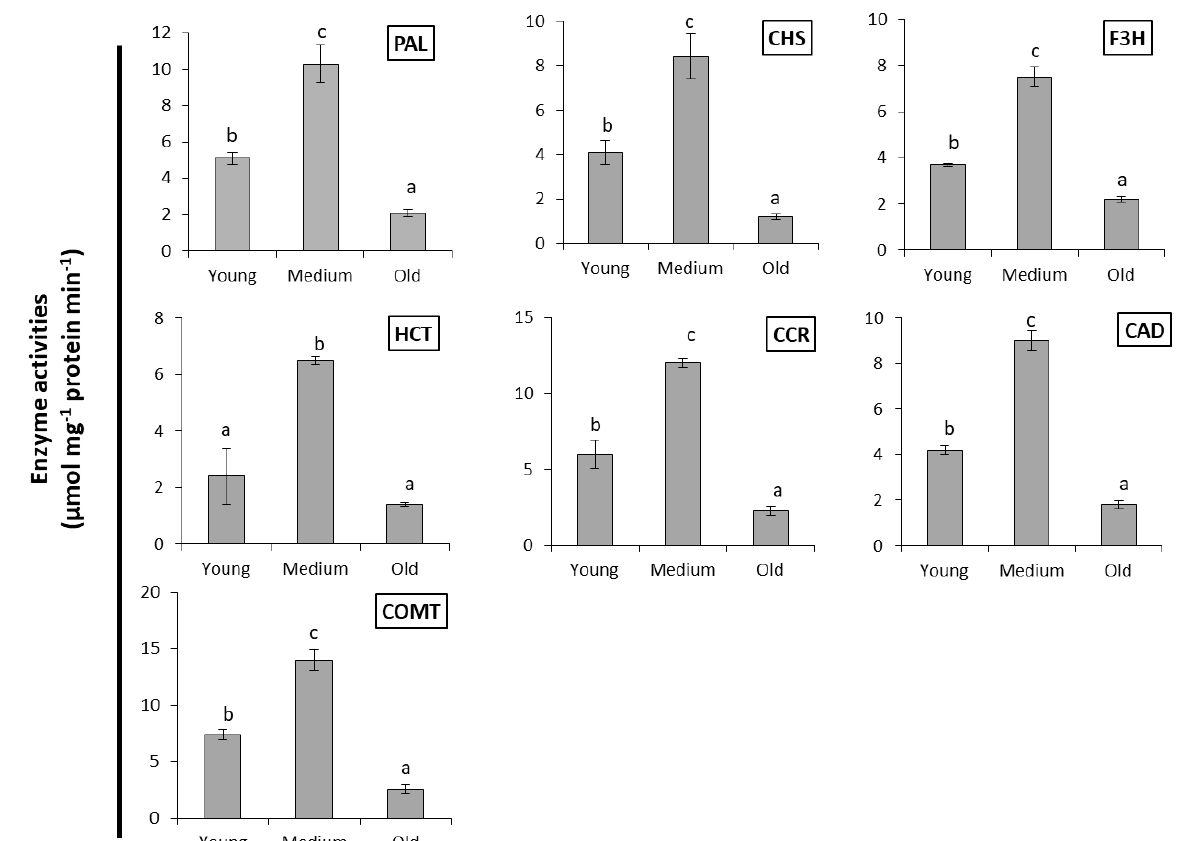
Figure 8. Enzyme activities (µmol mg −1 protein min −1 ) of phenylalanine ammonia lyase (PAL), chalcone synthase (CHS), flavonoid 3 ′ -monooxygenase (F3 ′ H), shikimate O- hydroxycinnamoyl transferase (HCT), cinnamoyl-CoA reductase (CCR), cinnamyl-alcohol dehydrogenase (CAD), and caffeoyl-CoA O -methyltransferase (COMT) in S. marianum leaves of different developmental stages. Data represent the mean ± SD ( n = 3). Different letters indicate significant difference ( p < 0.01) assessed by Tukey – Kramer ’ s test.